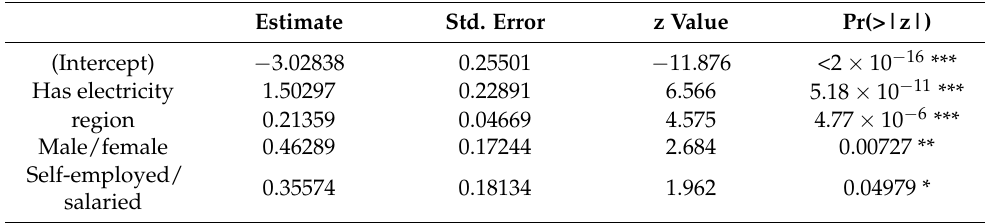
Table 4. Coefficients for best logistic regression model including all variables in Table 2, excluding mother’s